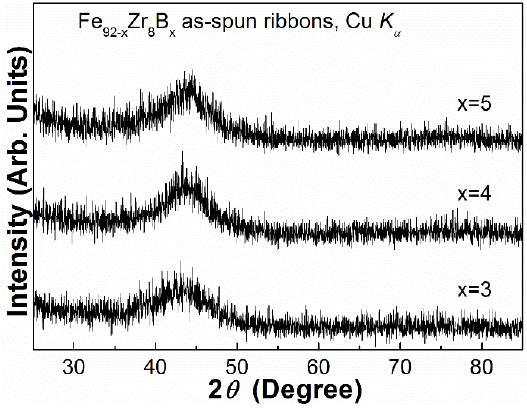
Figure 1. XRD patterns of the Fe 92-x Zr 8 B x (x = 3, 4, 5) as-spun ribbons.